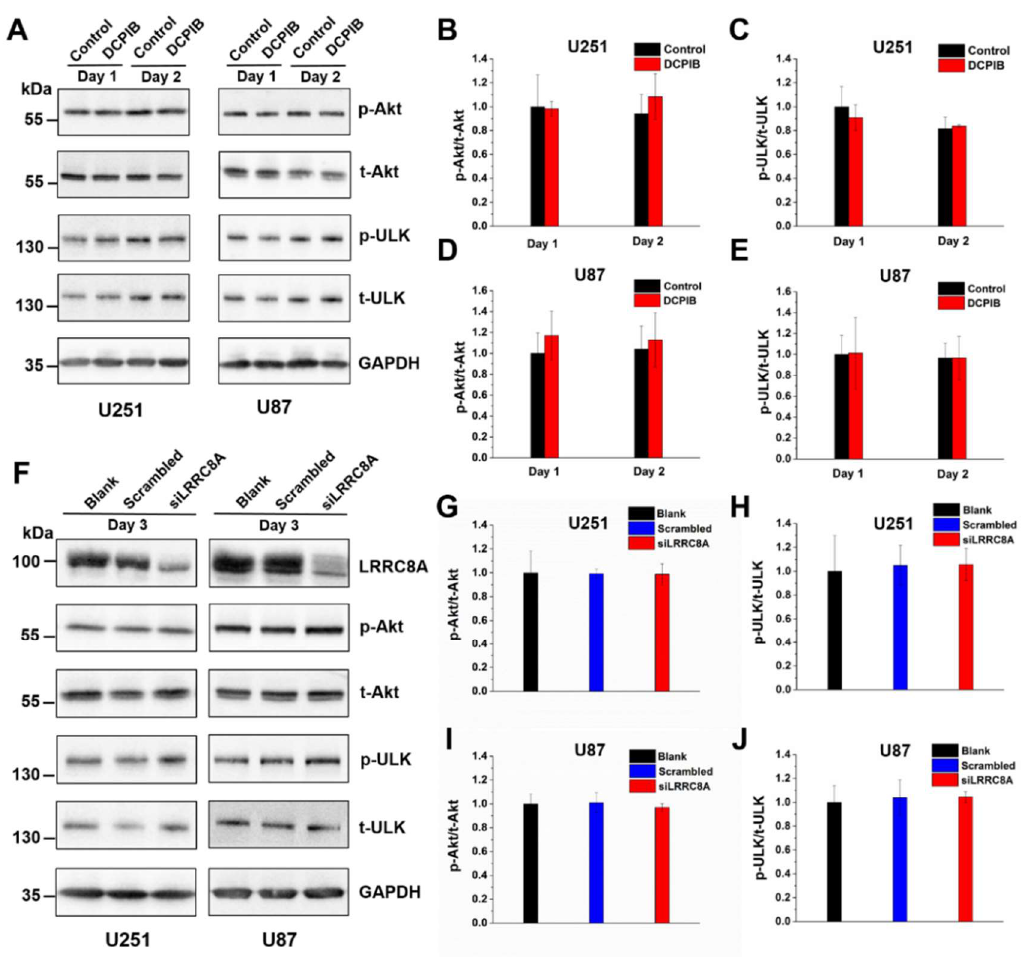
Figure 5. Treatment with DCPIB or siRNA-mediated knockdown of LRRC8A have no effects on PI3K / Akt signaling. ( A ) Western blot of GBM cells treated with DCPIB (100 µ M) at day 1 or day 2 for total amount and phosphorylated forms of Akt and ULK. GAPDH used as loading control. A representative blot of three independent experiments is shown. Analysis of the p -Akt / t-Akt ( B , D ) and p -ULK / t-ULK ( C , E ) ratio for U251 ( B , C ) and U87 ( D , E ) cells. ( F ) Western blotting of GBM cells for total amount and phosphorylated forms of Akt and ULK 72 h after siRNA transfection. For LRRC8A, the same samples were used as in Figure 4A and 4B. GAPDH used as loading control. A representative blot of three independent experiments is shown. Analysis of the p -Akt / t-Akt ( G , I ) and p -ULK / t-ULK ( H , J ) ratio for U251 ( G , H ) and U87 ( I , J ) cells. All data are presented as mean ± SD of n = 3 independent experiments.